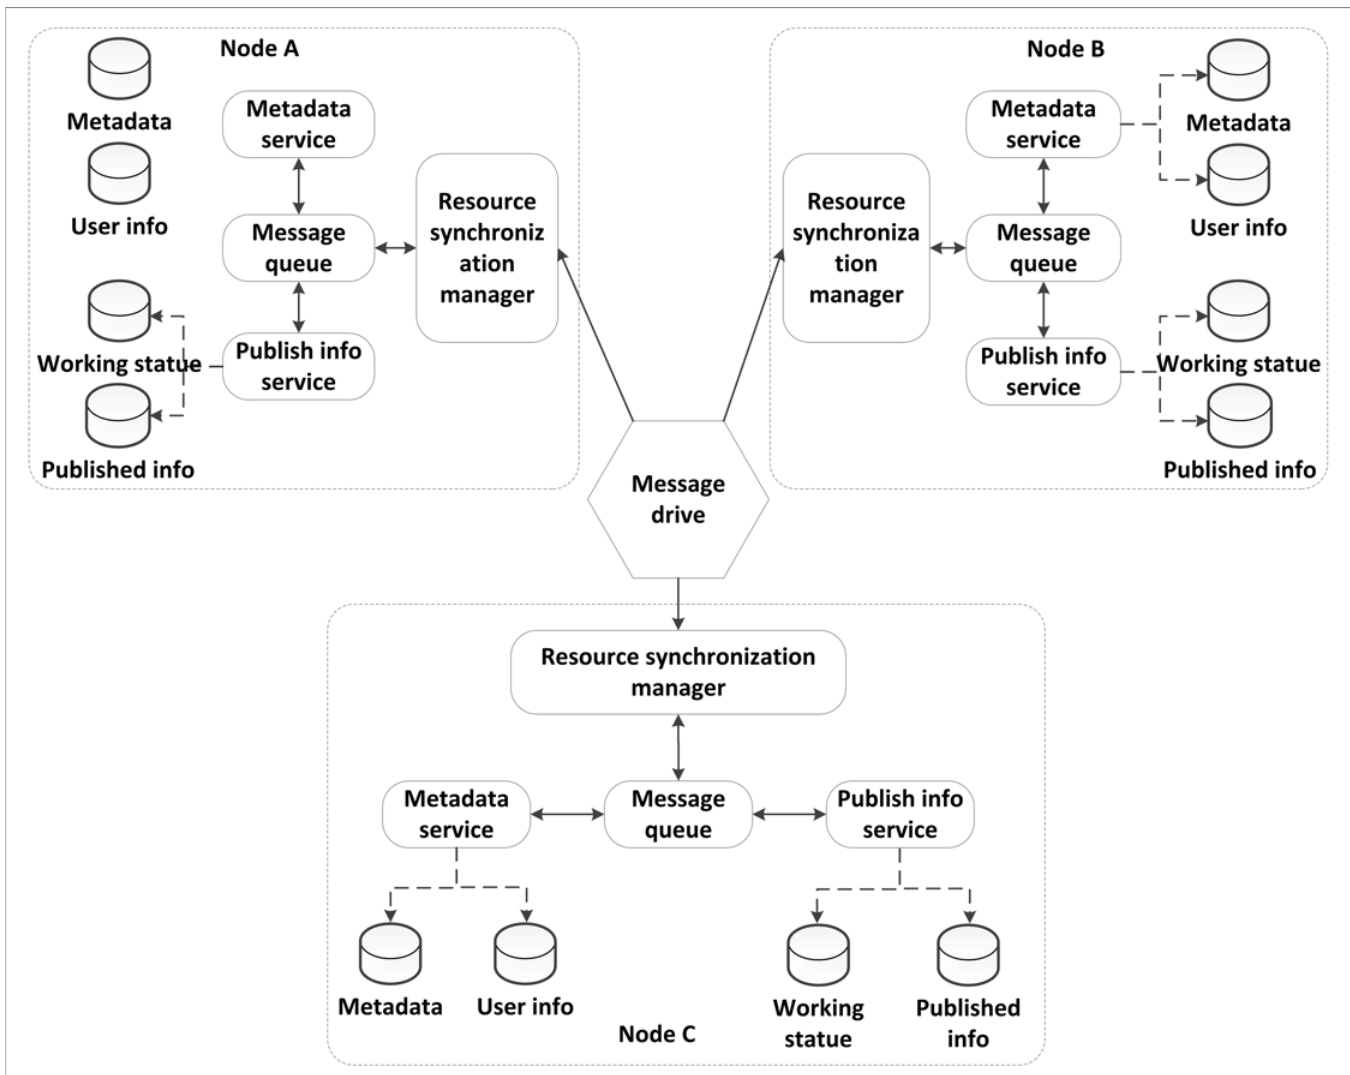
Fig 9. Resource synchronism of the node